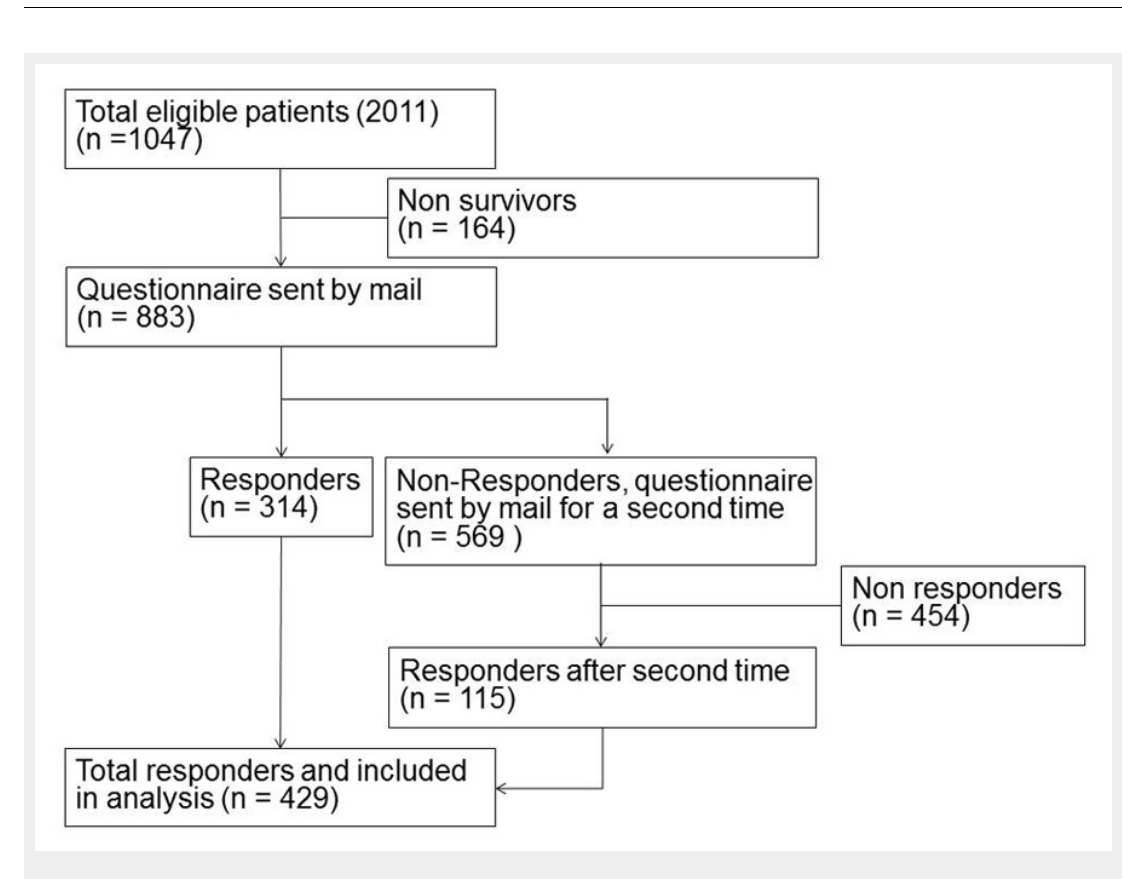
Figure 1 Patient inclusion flow chart